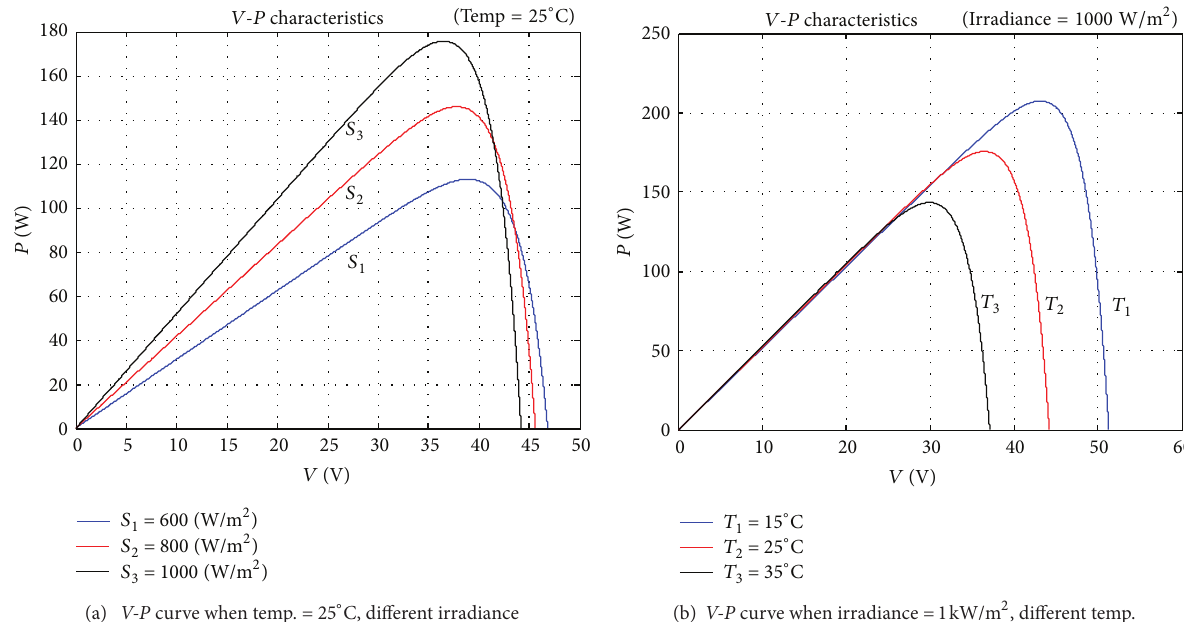
Figure 1: The output characteristics of PV cells.